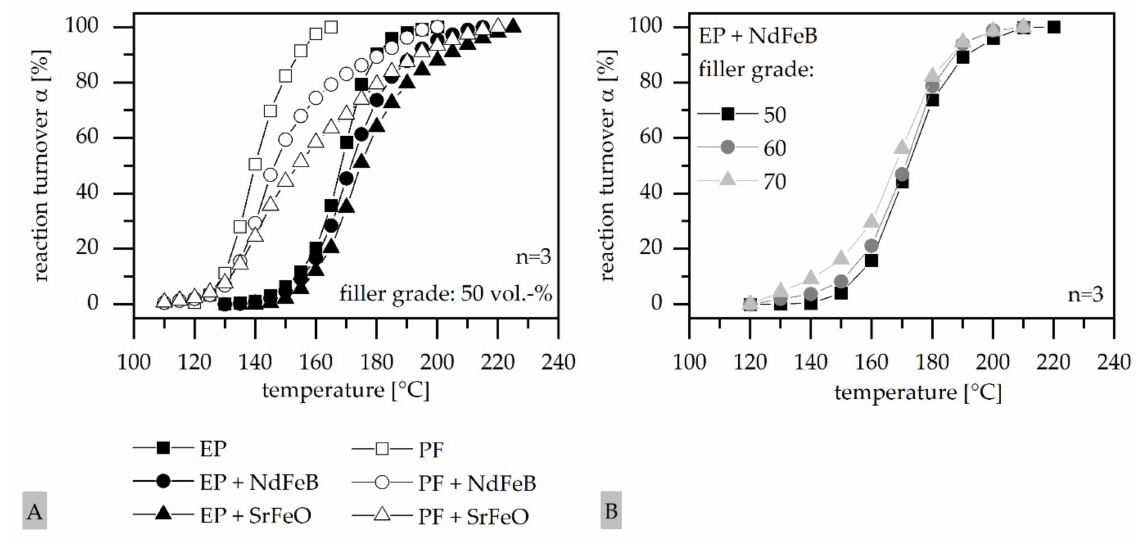
Figure 6. Reaction turnover α relative to the temperature for different matrix materials and fillers with constant filler grade of 50 vol.-% ( A ) and for different filler grades in EP with NdFeB ( B ) (SrFeO: strontium-ferrite-oxide; NdFeB: neodymium-iron-boron; PF: phenolic resin; EP: epoxy